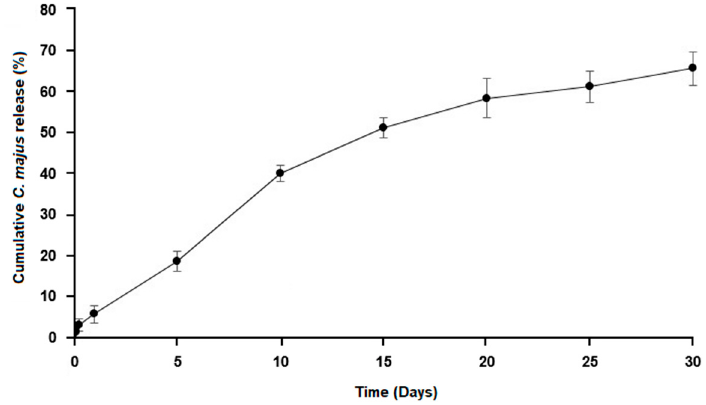
Figure 4. In Vitro release profile of C. majus from the produced electrospun PCL/PVA_PEC nanofibrous meshes.